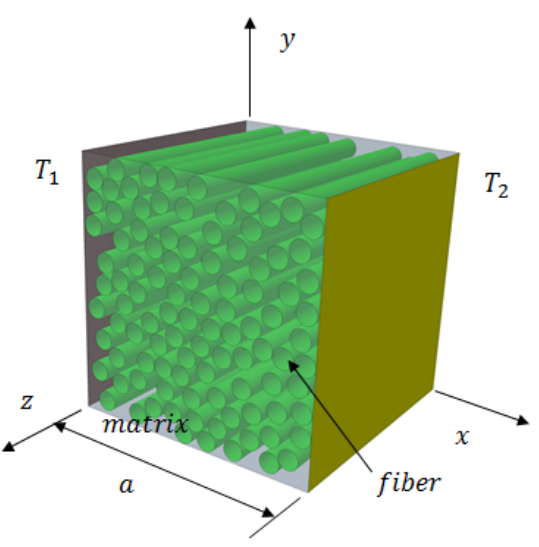
Figure 8: Schematic diagram of transverse heat transfer in the unit